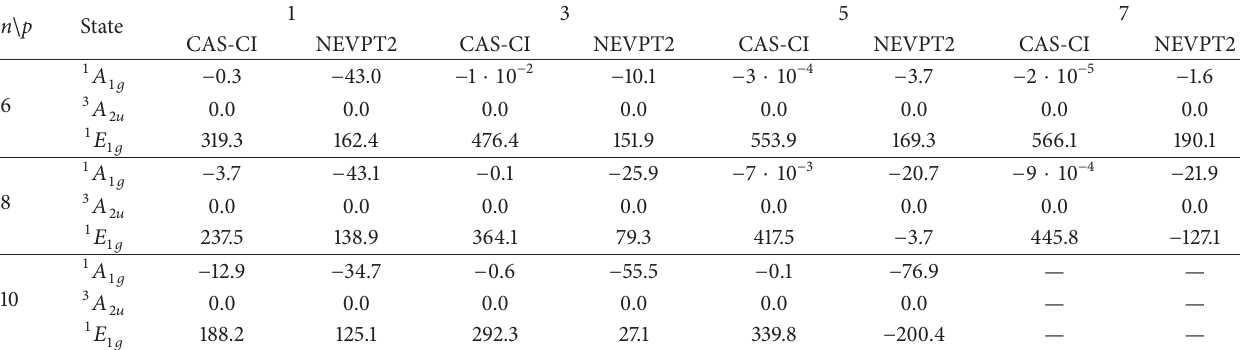
Table 3: CAS-CI and the NEVPT2 energies in kJmol −1 for the class of nanotubes 𝑛 𝑝 , with 𝑛 even and 𝑝 odd. All possible states for a CAS of two electrons in two orbitals have been calculated.